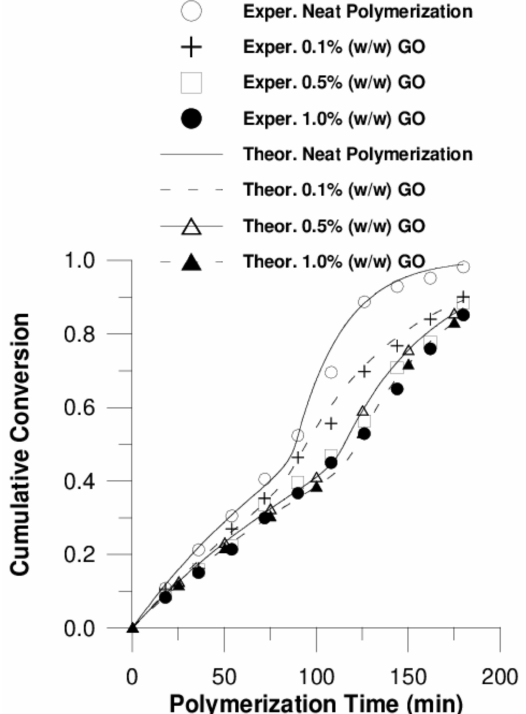
Figure 6. Cumulative conversion vs. polymerization time at various graphene oxide (GO) contents (Model I) for P(S- co -BMA)